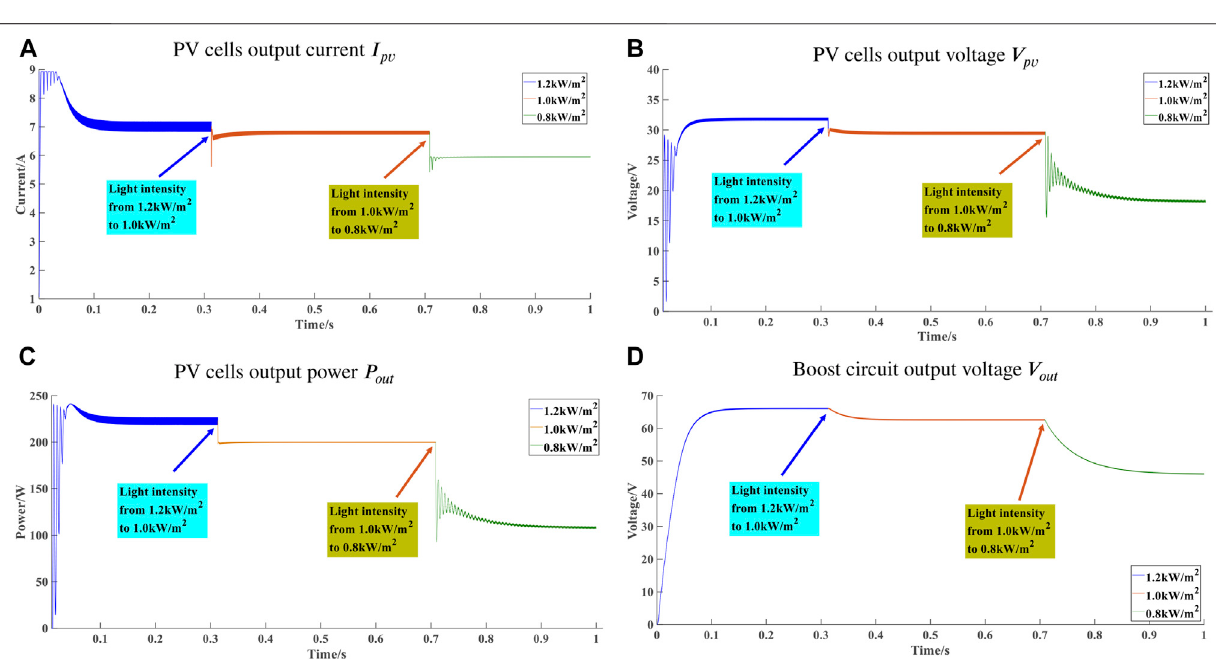
Frontiers in Energy Research |